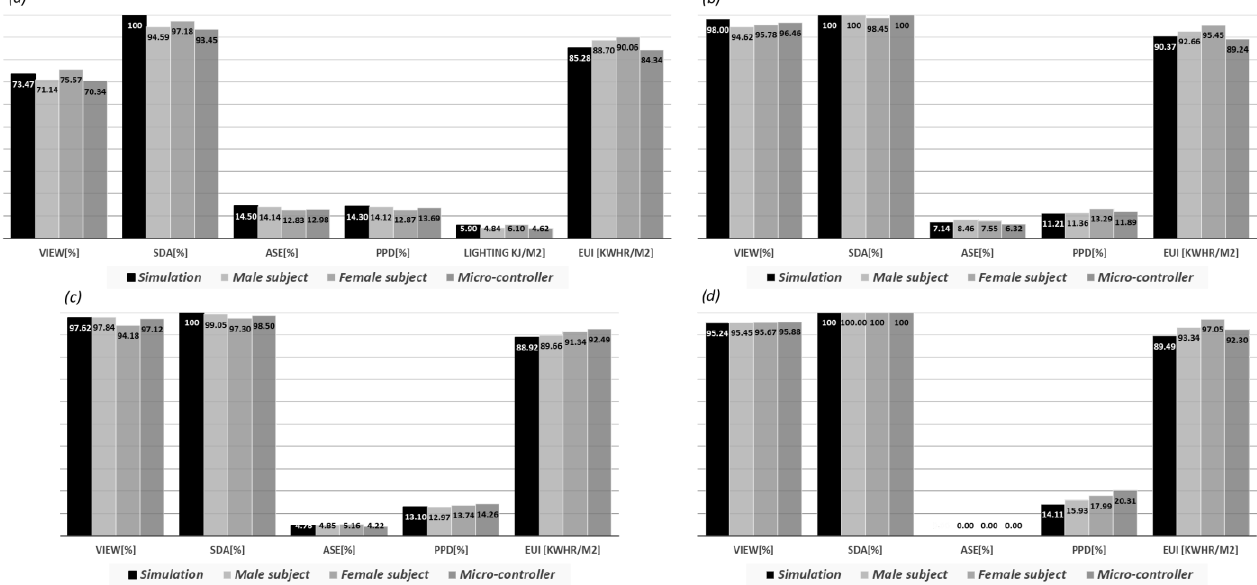
Figure 11. Validating the simulation result by comparing with observed outcomes for ( a ) north; ( b ) east; ( c ) west; and ( d ) south.